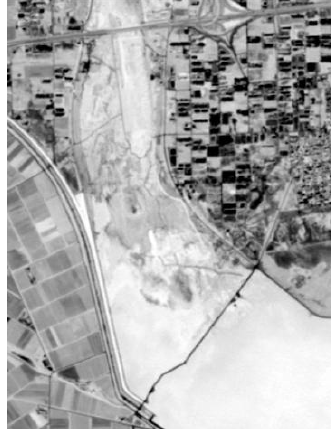
Figure 3a. Gallikos river - histogram equalization